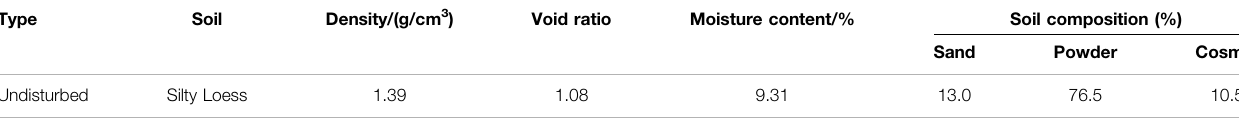
TABLE 1 | Soil physical property parameter table.